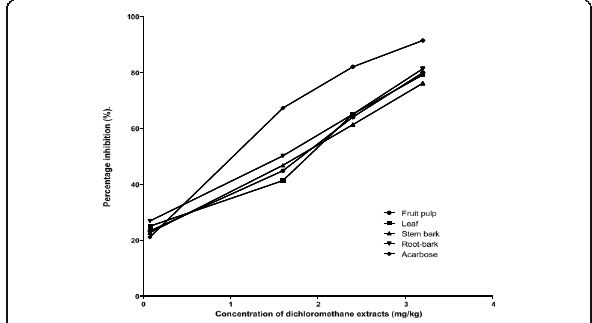
Fig. 6 Percentage inhibition of α -amylase by ethyl acetate extract of Annona muricata fruit-pulp, leaf, stem-bark, root-bark and acarbose (reference standard)